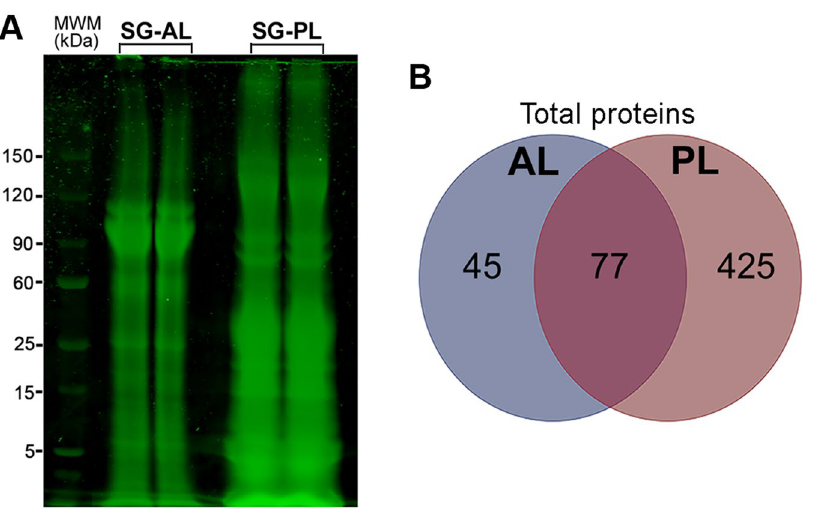
Figure 3. Proteomics analysis of Charonia tritonis anterior lobe (AL) and posterior lobe (PL) of the salivary gland (SG). ( A ) SDS-PAGE and Coomassie stain of extracts derived from the SG-AL and SG-PL. ( B ) Comparison of total proteins identified in extracts of SG-AL and SG-PL, based on Pfam